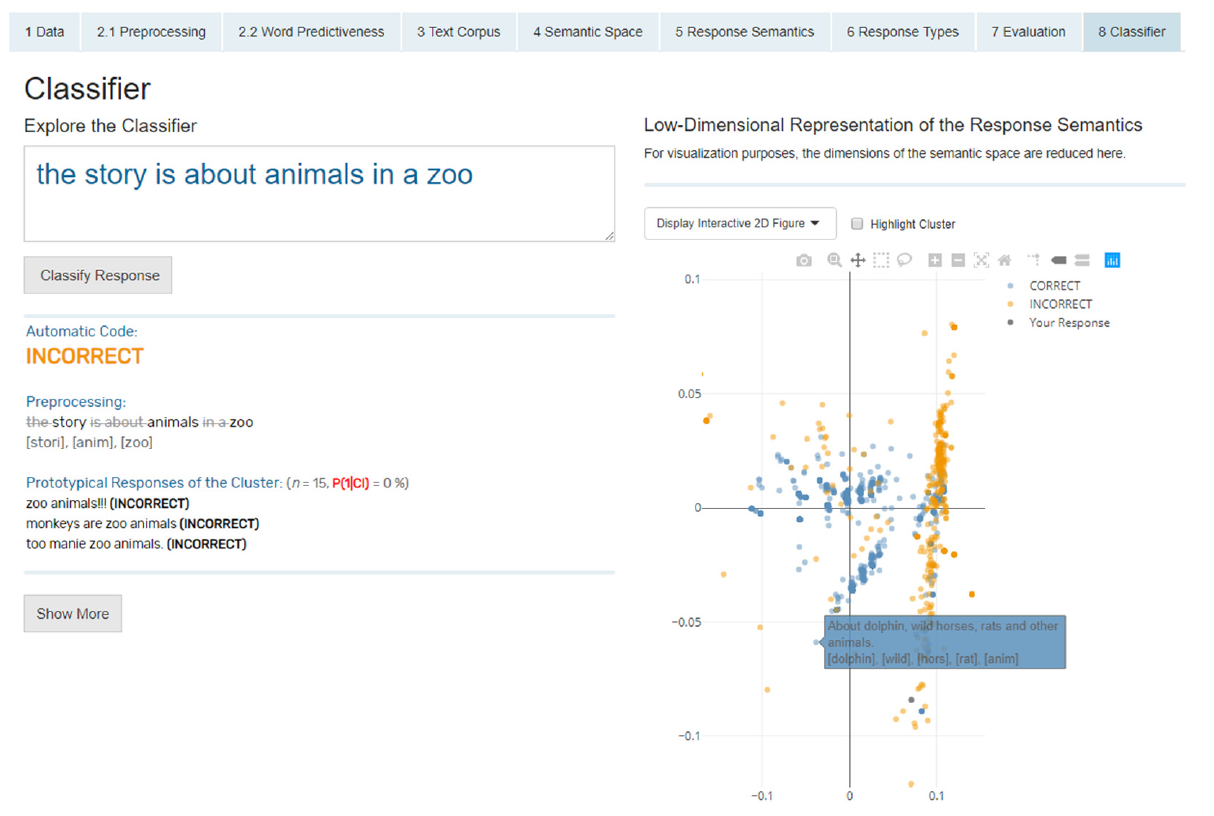
Figure 10. Exploring the classifier in shinyReCoR.